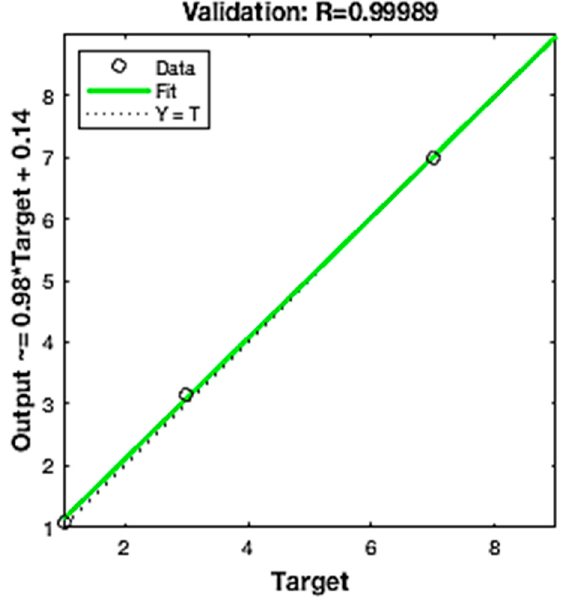
Figure 8. Regression outcomes in the validation phase of the proposed MLANN.